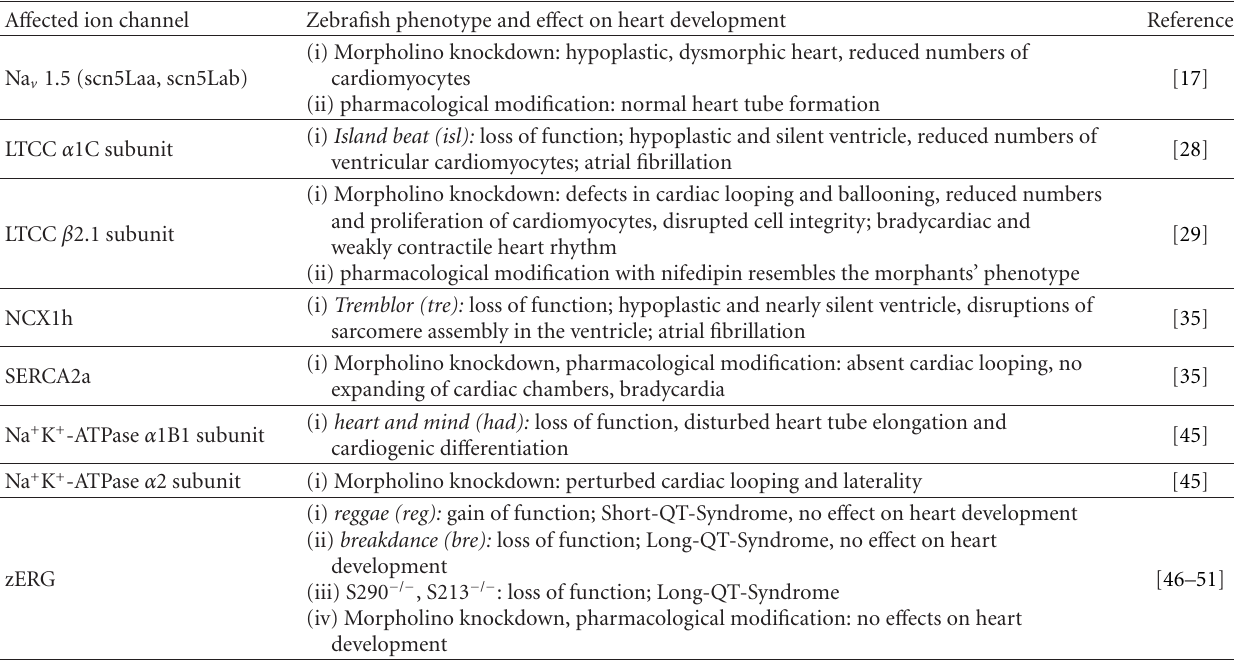
Table 1: A ff ected ion channel and e ff ect on heart